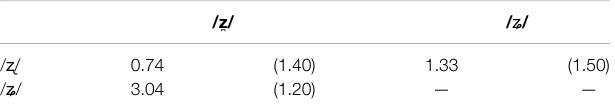
TABLE 5 | Mean d-prime values for each comparison in the Polish experimental block (SD in brackets).